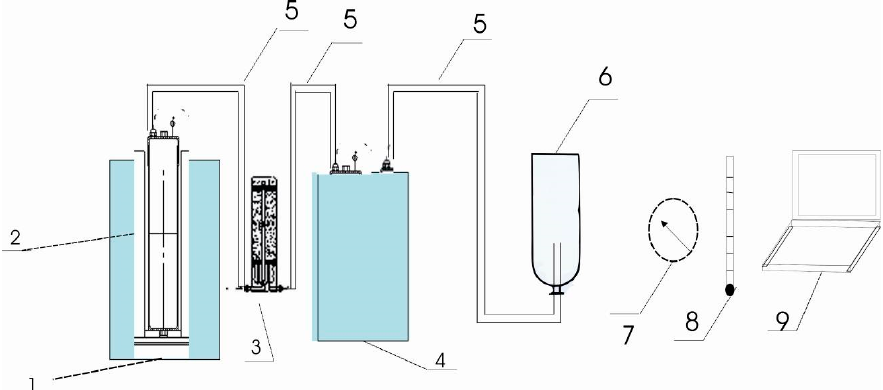
Figure 2. The ISO-300 filed testing system of desorption gas content in the Da’anzhai shale member.1-thermostatic apparatus; 2-desorption tank; 3-dehumidication apparatus; 4-testing instruments of gas flow; 5-flexible pipe; 6-device for collecting gas; 7-pressure gauge; 8-thermometer; 9-data-processing system.